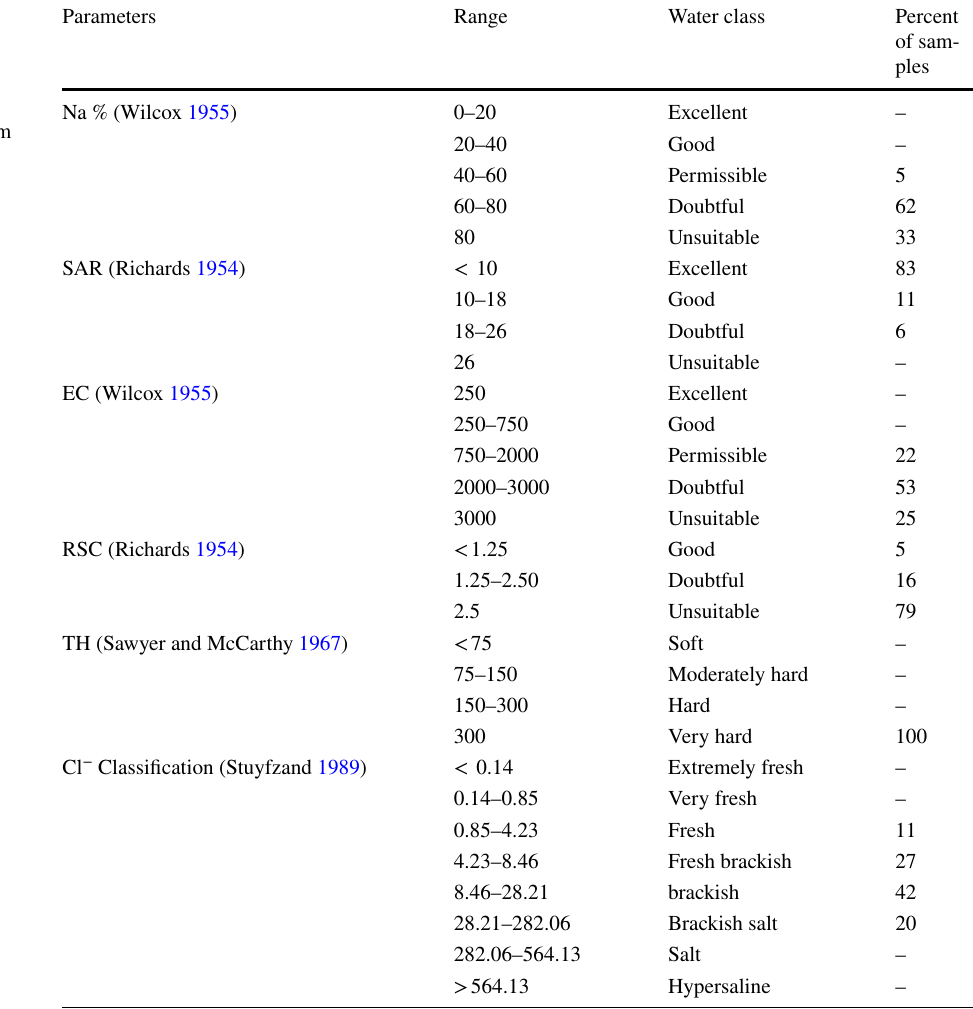
groundwater based on total hardness (TH), electrical conductivity (EC), chloride concentration, sodium adsorption ratio (SAR), sodium percent (%Na), and residual sodium carbonate